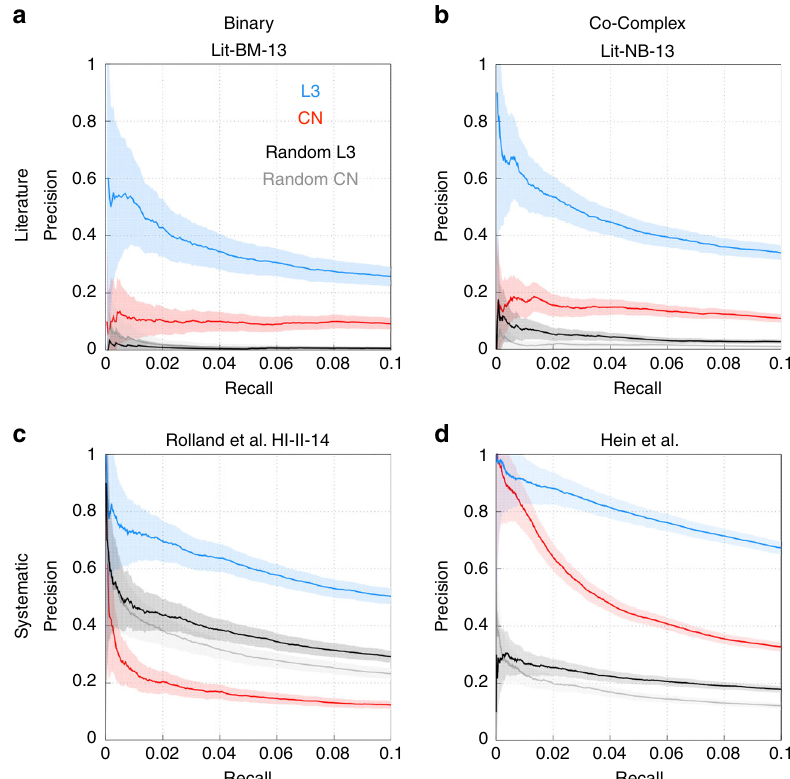
Fig. 2 L3 outperforms Common Neighbors (CN) on PPI networks. Monte Carlo cross-validation of CN (a TCP implementation) and L3 on the four possible PPI data sources, arising from literature curation with multiple evidences ( a , b 5 ) or systematic screens ( c 5 , d 6 ). We randomly select 50% of the PPIs and use it as the input network to predict the rest of the PPIs. Precision is the fraction of interacting proteins vs. all predicted pairs, while recall stands for the fraction of predicted PPIs compared to the number of test PPIs. We use all predictions until a 10% recall value is reached in each network. We fi nd that L3 outperforms CN in all cases. We fi nd qualitatively very similar results in a k -fold cross-validation scenario, as shown in the limit of an exhaustive leave-one- out cross-validation in Supplementary Fig. 10. In addition, we show the performance of both methods on randomized networks, where only the node degrees are preserved. L3 outperforms both these random benchmarks, irrespectively of the data source. In the case of the systematic binary network, HI- II-14, CN performs worse than in the randomized network, indicating a fundamental failure of TCP to capture the patterns shaping the underlying network structure. The shading around each curve indicates the standard deviation over 10 different random selections of the input PPIs. For additional datasets